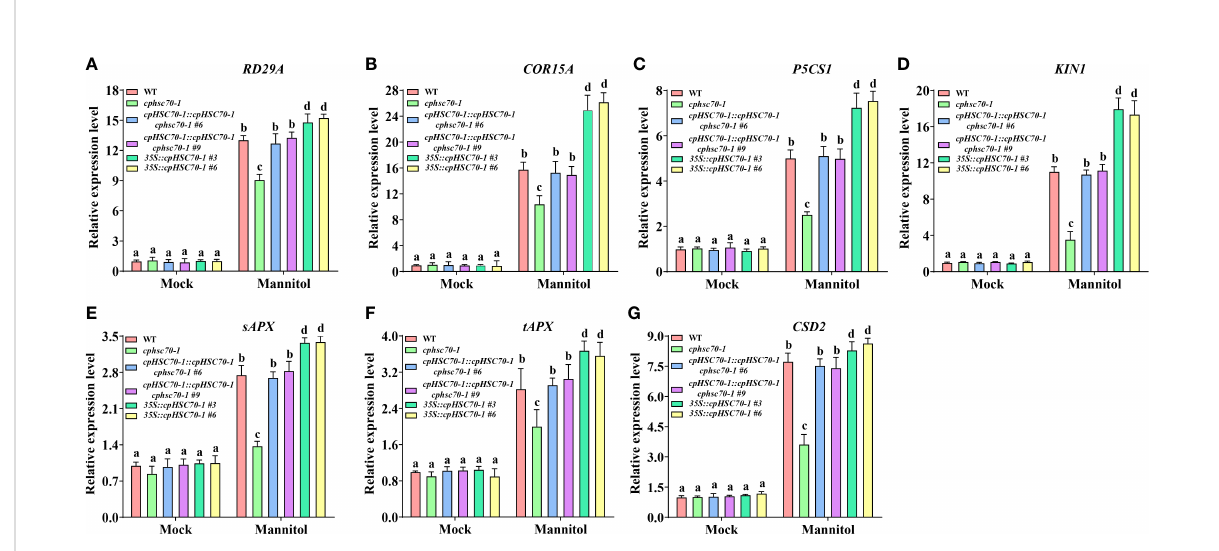
FIGURE 4 Effects of cpHSC70-1 on expression of genes involved in stress response and ROS-scavenging system. (A – G) The expression levels of (A) RD29A , (B) COR15A , (C) P5CS1 , (D) KIN1 , (E) sAPX , (F) tAPX , and (G) CSD2 of the 5-day-old wild-type, cphsc70-1 , cpHSC70-1::cpHSC70-1 cphsc70-1 , and 35S::cpHSC70-1 plants treated with or without (Mock) 300 mM mannitol for 12 h. The expression of these genes was determined by RT-qPCR and correlated with that of the WT, the value of which was set as 1. ACTIN2 was used as the reference gene. The data are means ( ± SEM) from at least three independent experiments. Different letters indicate signi fi cant differences as determined using ANOVA followed by Tukey ’ s test ( p <